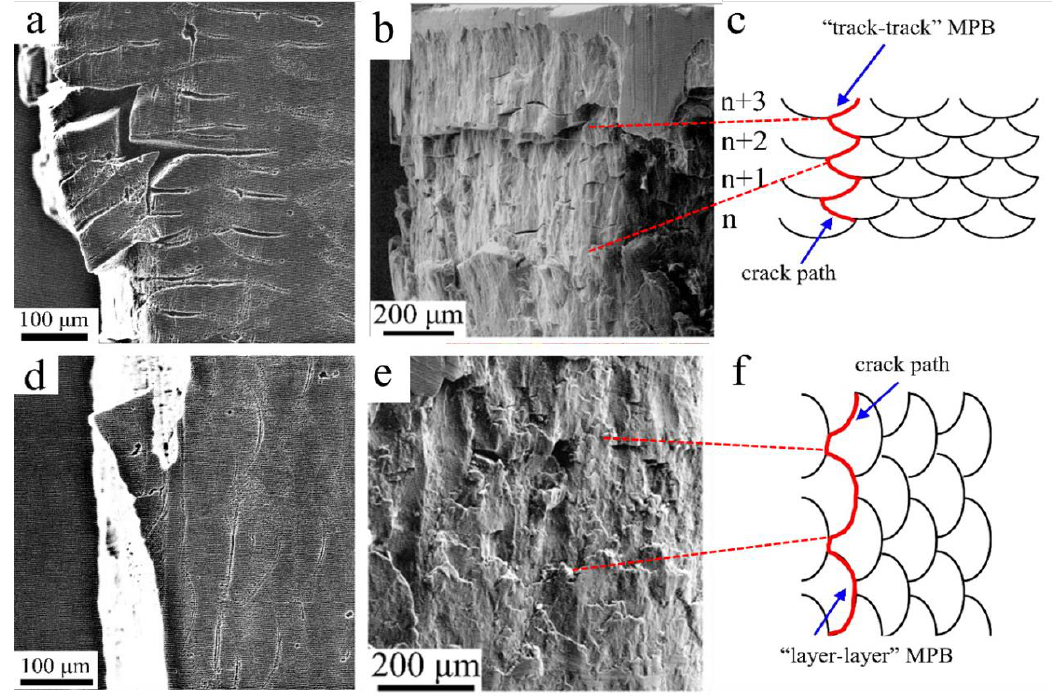
Figure 4. (a), (b) and (d), (e)-SEM images of the fracture surface closest to the shear zone. (c)and (f) scheme of the crack path. Z samples –(a)-(c), XY samples